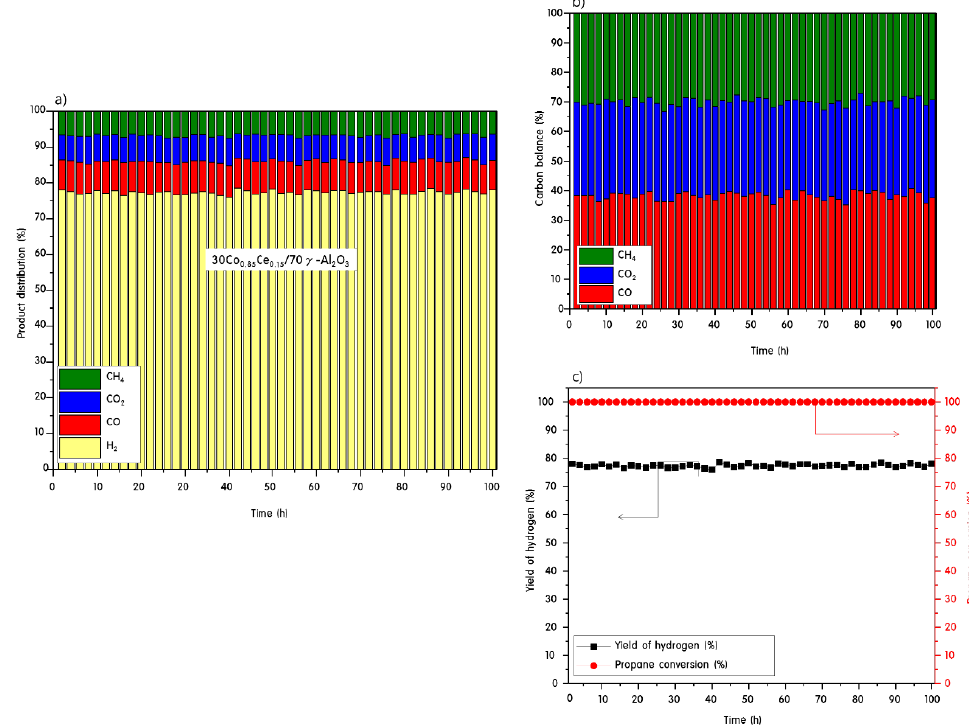
Figure 8. Product distributions ( a , b ) and hydrogen yield and propane conversion ( c ) for the 30Co 0.85 Ce 0.15 /70γ-Al 2 O 3 catalyst during the PSR reaction at 700 °C over 100 h. 30Co 0.85 Ce 0.15 /70 γ -Al 2 O 3 catalyst during the PSR reaction at 700 ◦ C over 100